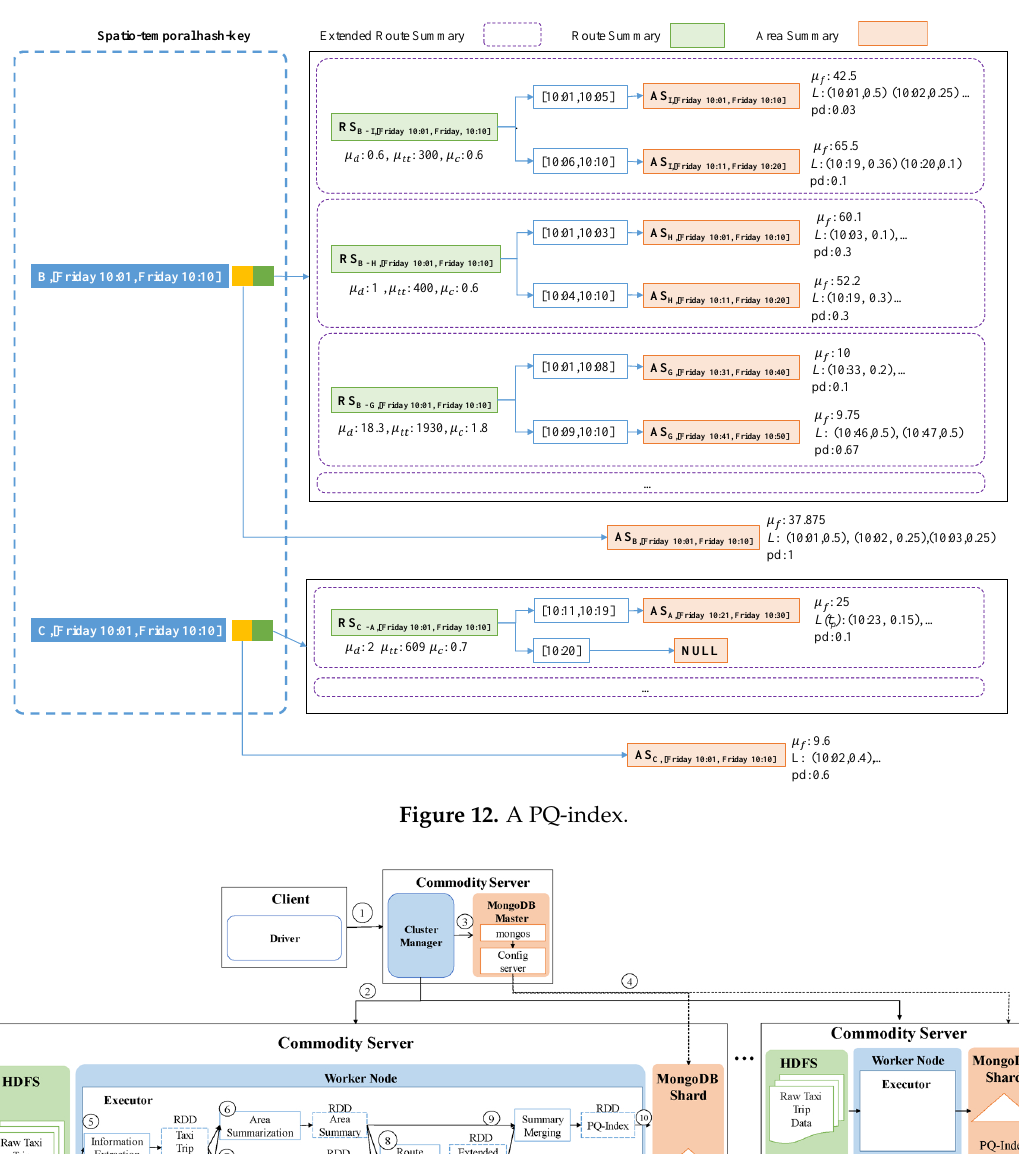
Figure 13. Distributed construction of a